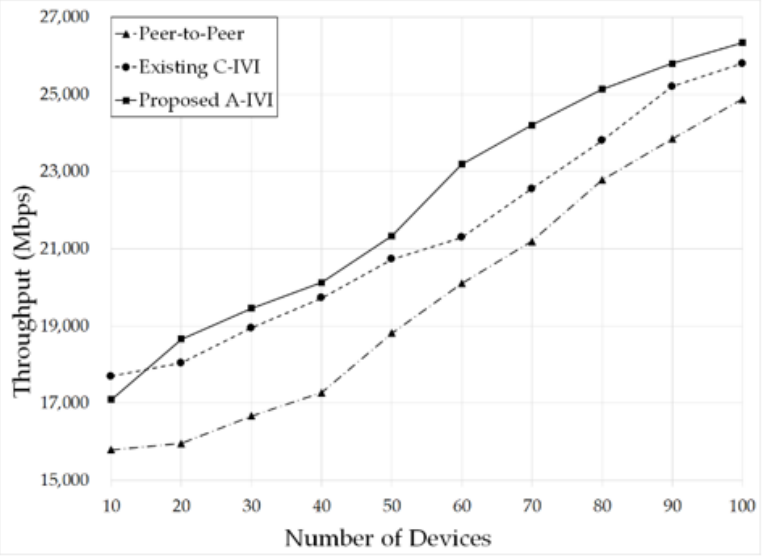
Figure 27. Throughput for different number of devices.